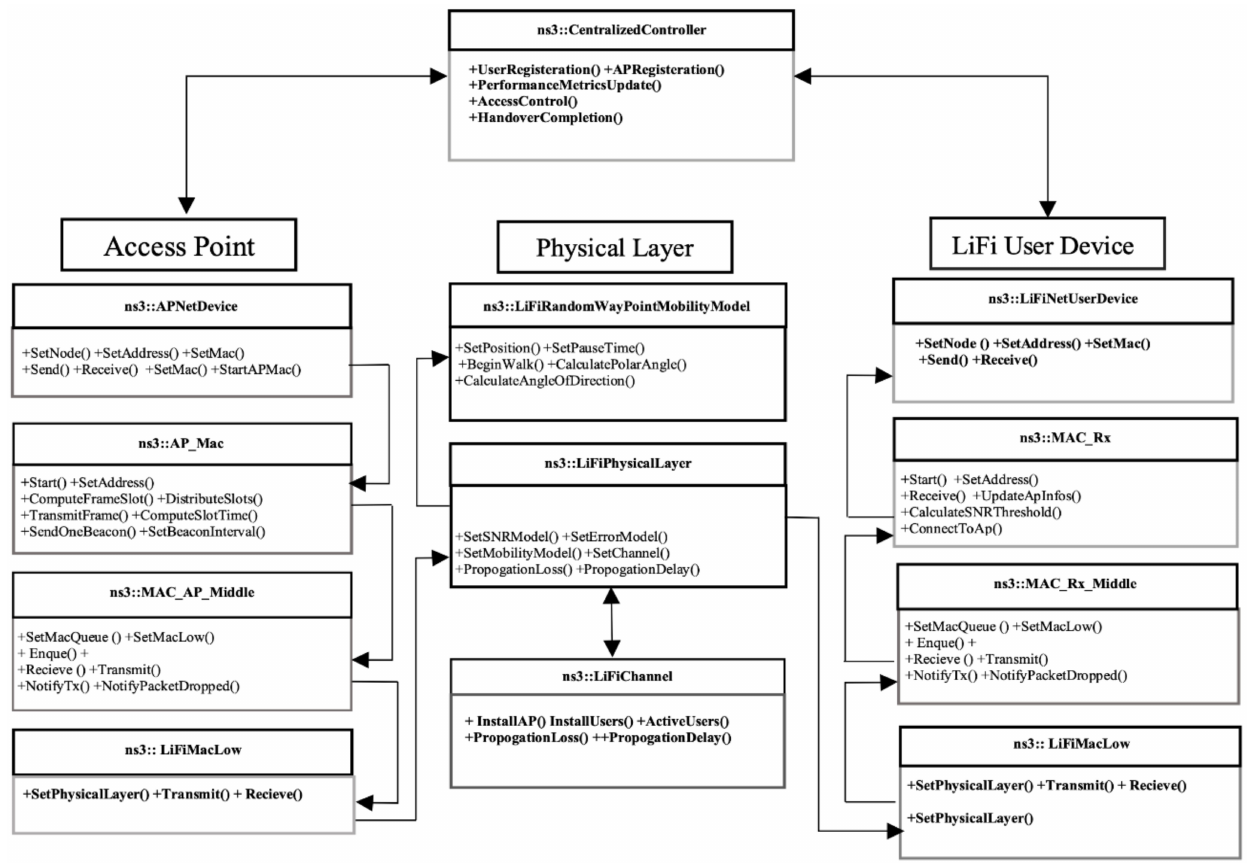
Figure 2. LiFi ns-3